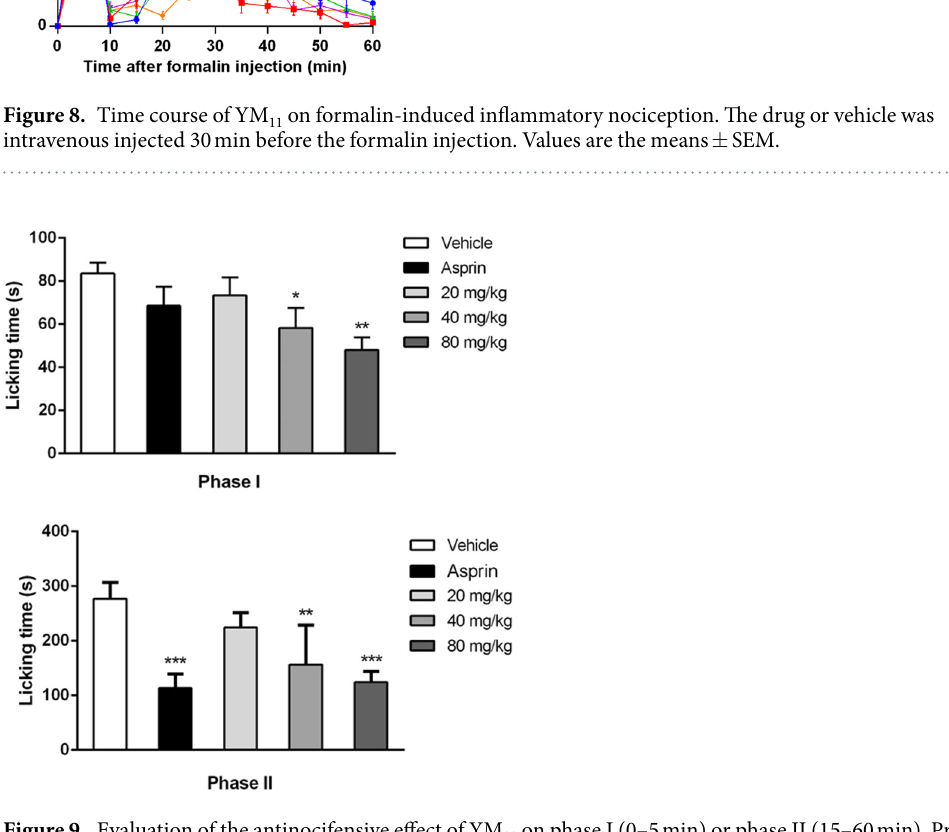
Figure 9. Evaluation of the antinocifensive effect of YM 11 on phase I (0–5 min) or phase II (15–60 min). Pre- treatment of YM